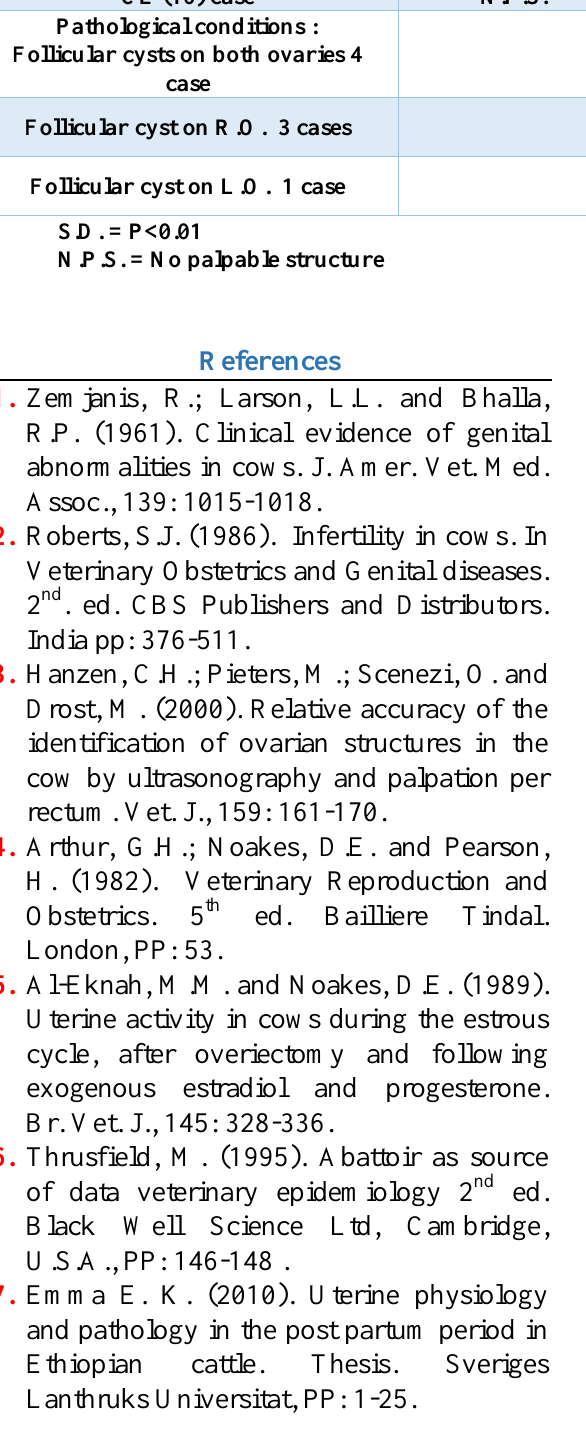
Progesterone N mol/L 2.43±1.03 0.9 0.7 0.5